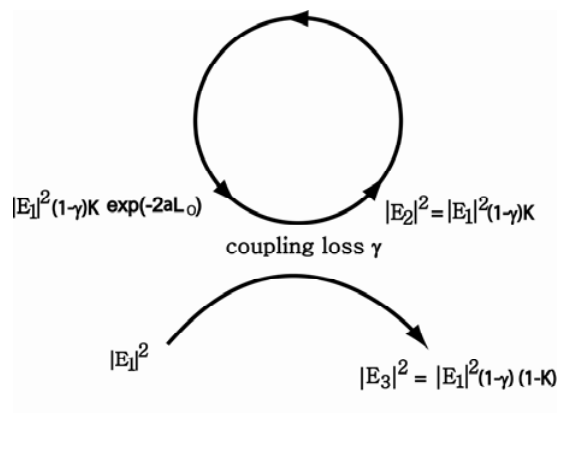
Figure 11. Model of wave